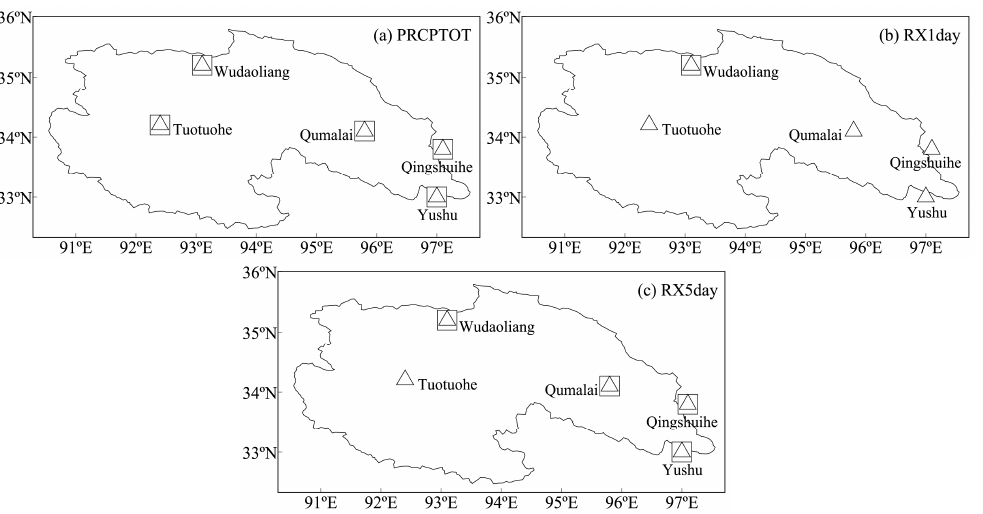
Figure 5. Spatial patterns of trends for the dry season for the indices of ( a ) PRCPTOT, ( b ) RX1day, and ( c ) RX5day over the SRYR during 1960–2016. Increasing (decreasing) trends are marked by upright triangles (inverted triangles), while statistically significant trends (at a 5% significant level) are marked by square symbols.